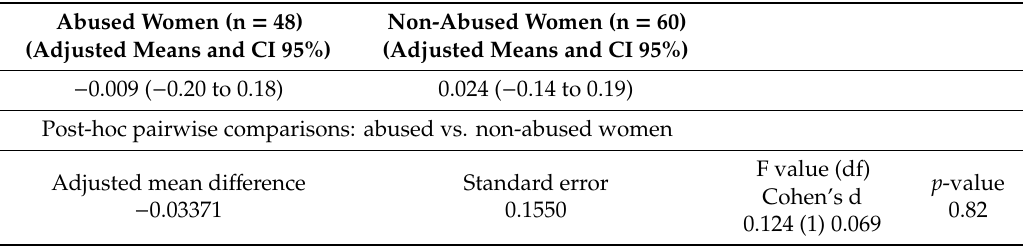
Table 2. The Analysis of Covariance (ANCOVA) of short-term relationship with adjusted means weighted for the covariates and Cohen’s d e ff ect size.